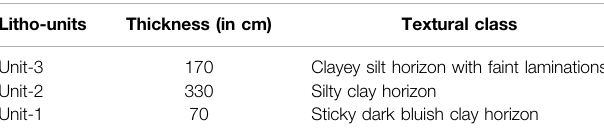
TABLE 1 | Lithostratigraphic information for the BKR trench site,